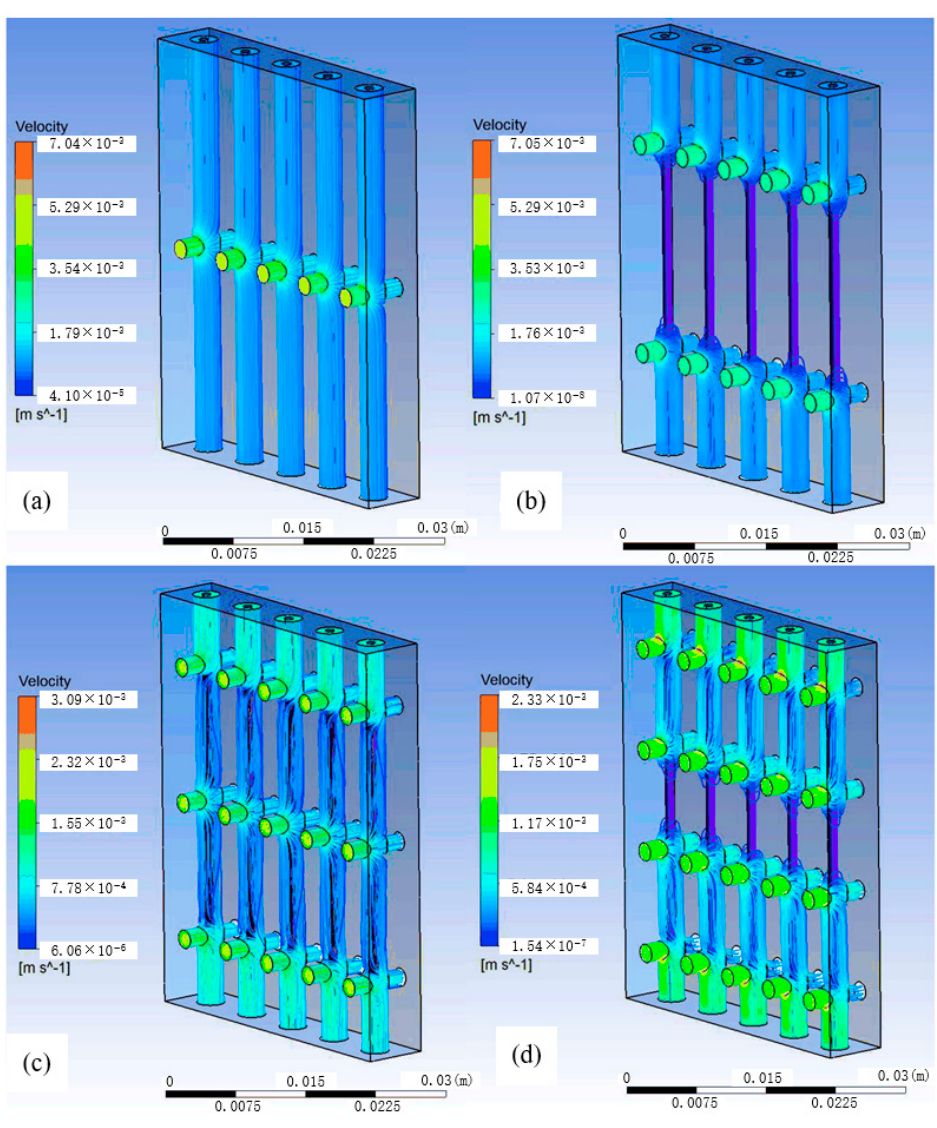
Figure 13. The flow field in a reaction element with ( a ) Ny = 1, ( b ) Ny = 2, ( c ) Ny = 3, and ( d ) Ny = 4.